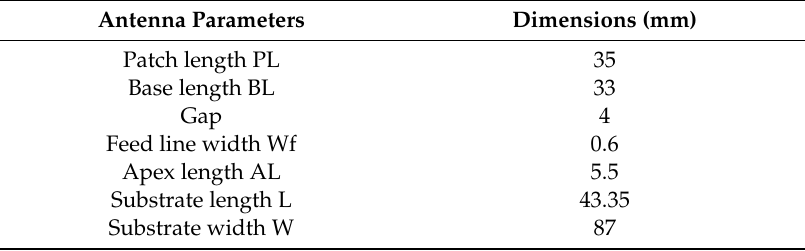
Table 1. Antenna A